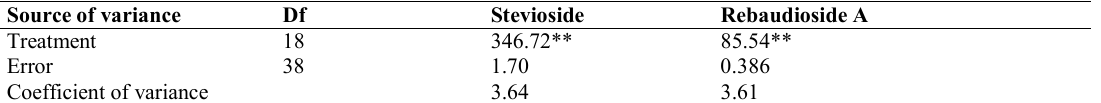
Table 5 . Variance analysis of glycoside sugar content (stevioside and ribodioside) of samples treated by EMS Source of variance